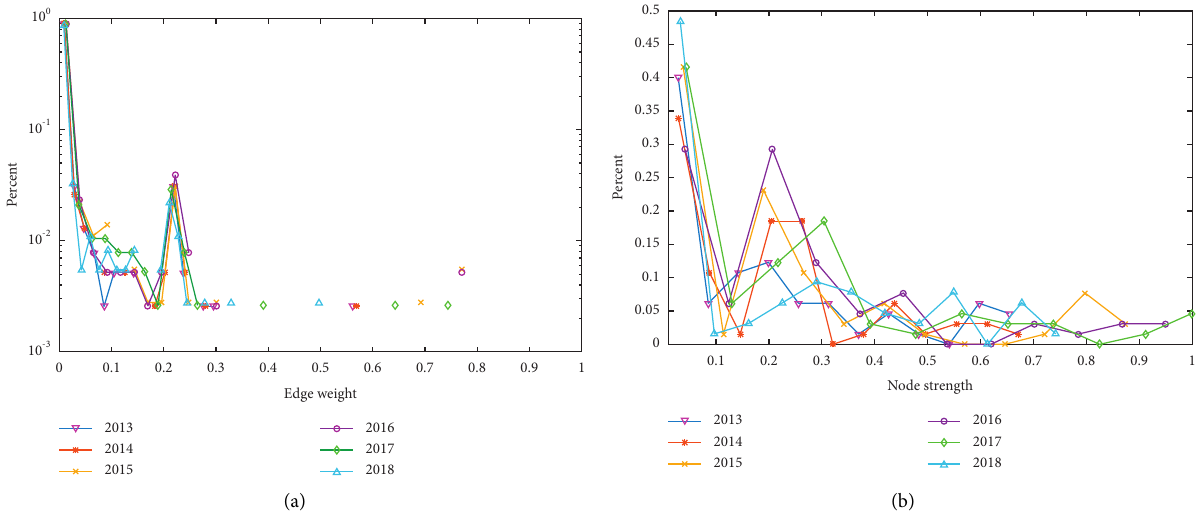
Figure 6: Weighted edge distribution and node strength distribution. (a) Edge weight. (b) Node strength.